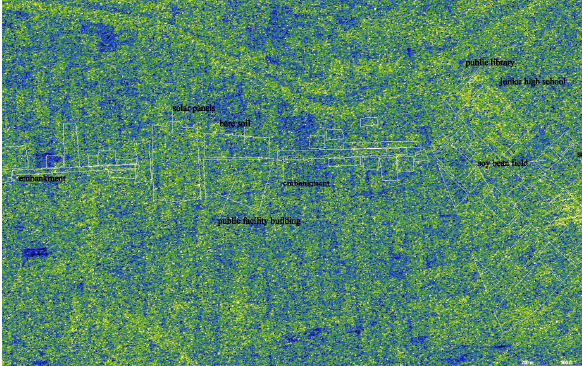
Figure 9. Zooming the RVI result of middle part of Figure 7. image